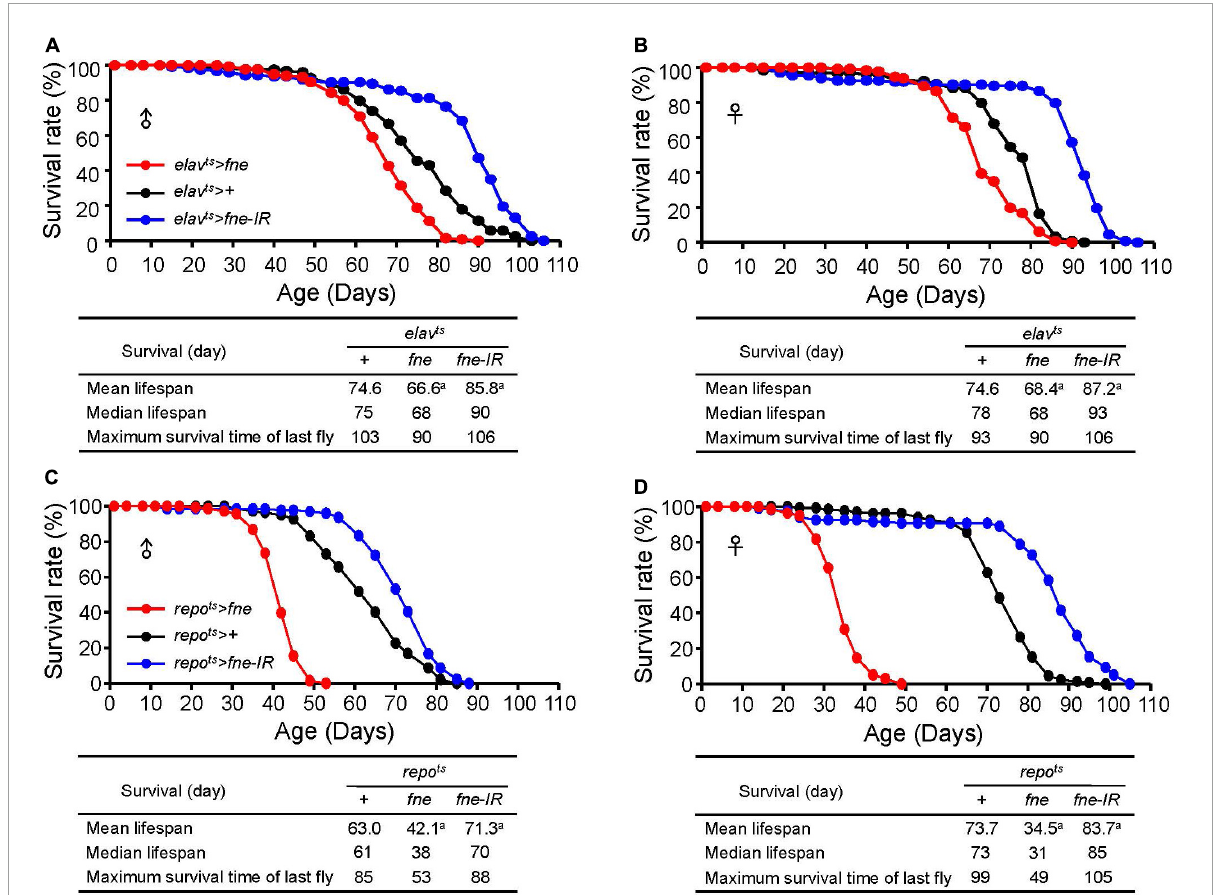
FIGURE9 Effects of fne expression on the lifespan in neurons and glia. The survival curve of overexpression and knockdown of fne in neurons. Data represent the total lifespan of examined (A) male and (B) female flies. The genotypes of each group are elav ts > fne (red circle), elav ts > + (black circle), and elav ts > fne-IR (blue circle). The total lifespan of overexpression and knockdown of fne in glia represents in (C) male and (D) female flies. The genotypes of each group are repo ts > fne (red circle), repo ts > + (black circle), and repo ts > fne-IR (blue circle). Flies were reared